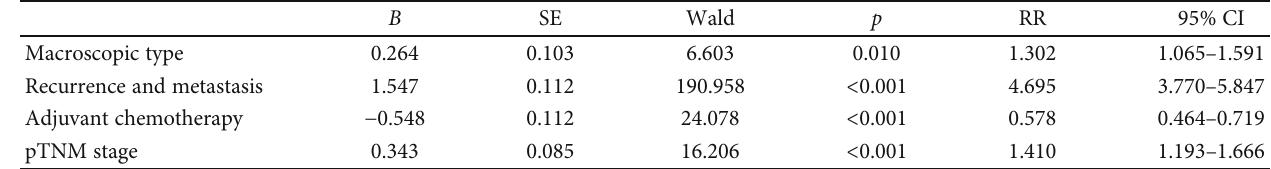
Table 2: Multivariate analysis of tumor characteristics and upper gastric cancer